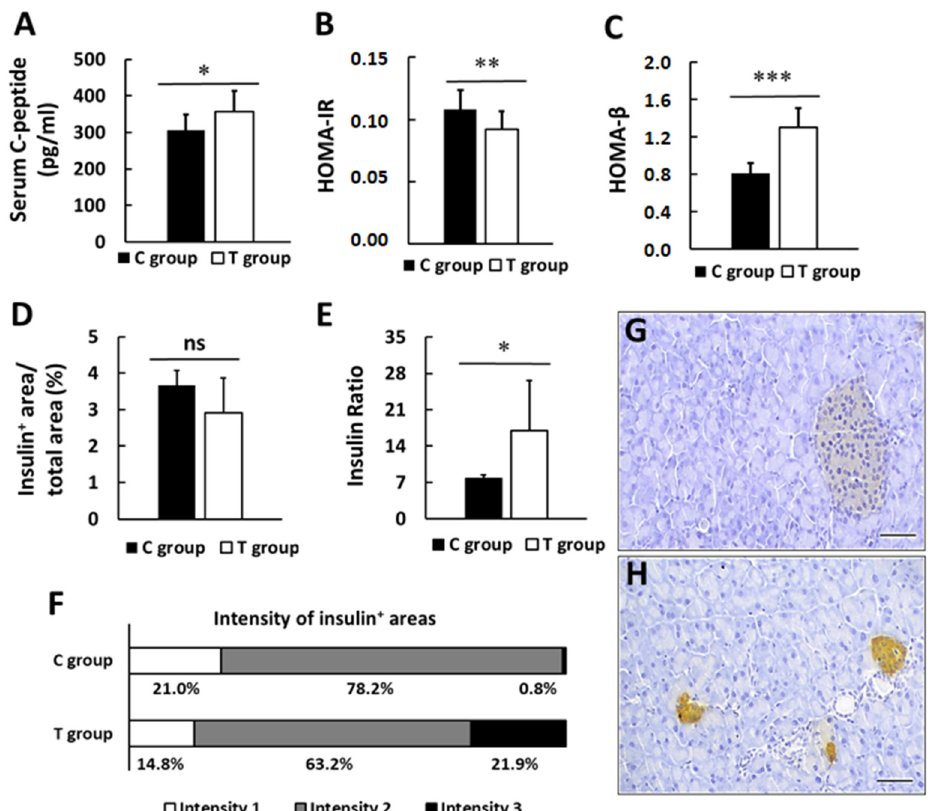
Figure 4. Impact of probiotic supplementation on pancreatic activity. ( A ) Serum C-peptide levels. ( B ) HOMA-IR index. ( C ) HOMA- β index. ( D ) Insulin positive area per total area. ( E ) Insulin Ratio (C-peptide level per insulin positive area/total area). ( F ) Intensity of insulin positive areas. Representative images of pancreas sections immunohistochemically-stained for insulin C group ( G ) and T group ( H ). Values are expressed as mean ± SD. * p < 0.05, ** p < 0.01, *** p < 0.001. ns: no significance. Scale bars: 50 µm.